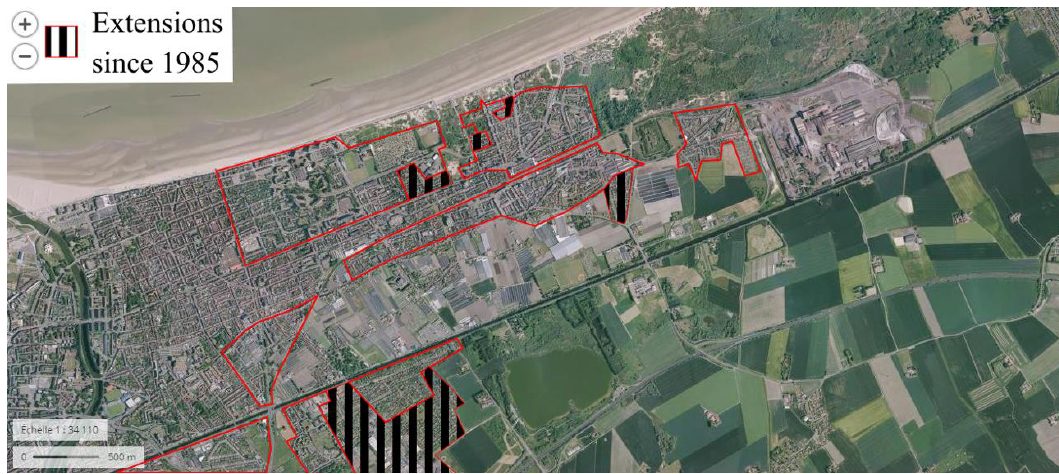
Figure 7. East part of Dunkirk, Leffrinckoucke, in 2015, with the extensions of the city after and before the creation of the Shoreline Act . Picture of the service “Géoportail” from the French National institute of Geographic and Forest Information (IGN).